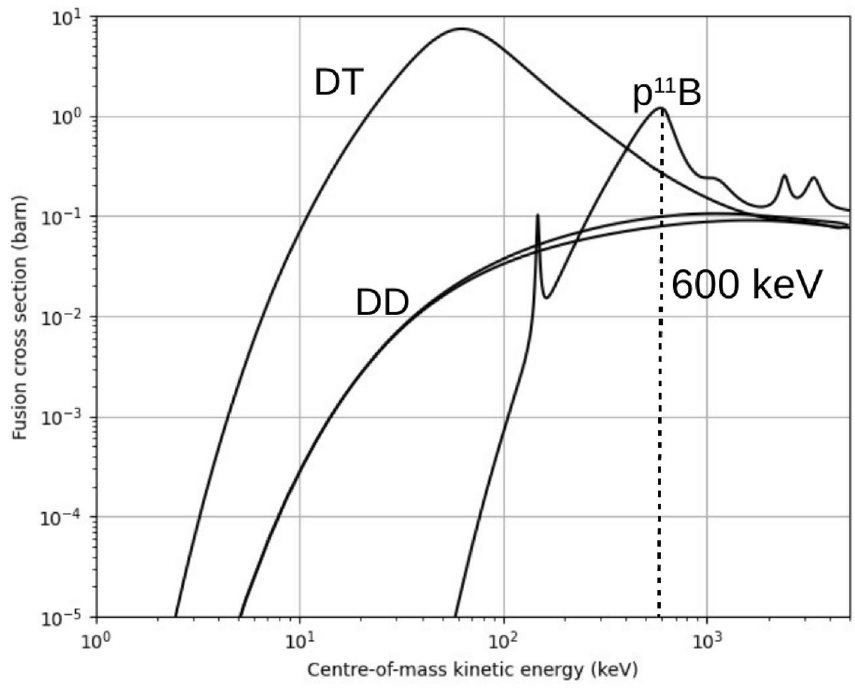
Figure 2. Fusion cross-sections of Deuterium–Tritium (DT), Deuterium–Deuterium (DD) and proton–Boron 11 (p– B) as a function of the center of mass kinetic energy. The dotted line indicates the energy of the higher cross-section resonance ( 600 keV). For DT and DD fusion cross-sections, see Ref. 35 and for pB fusion, see ∼ Ref. 36